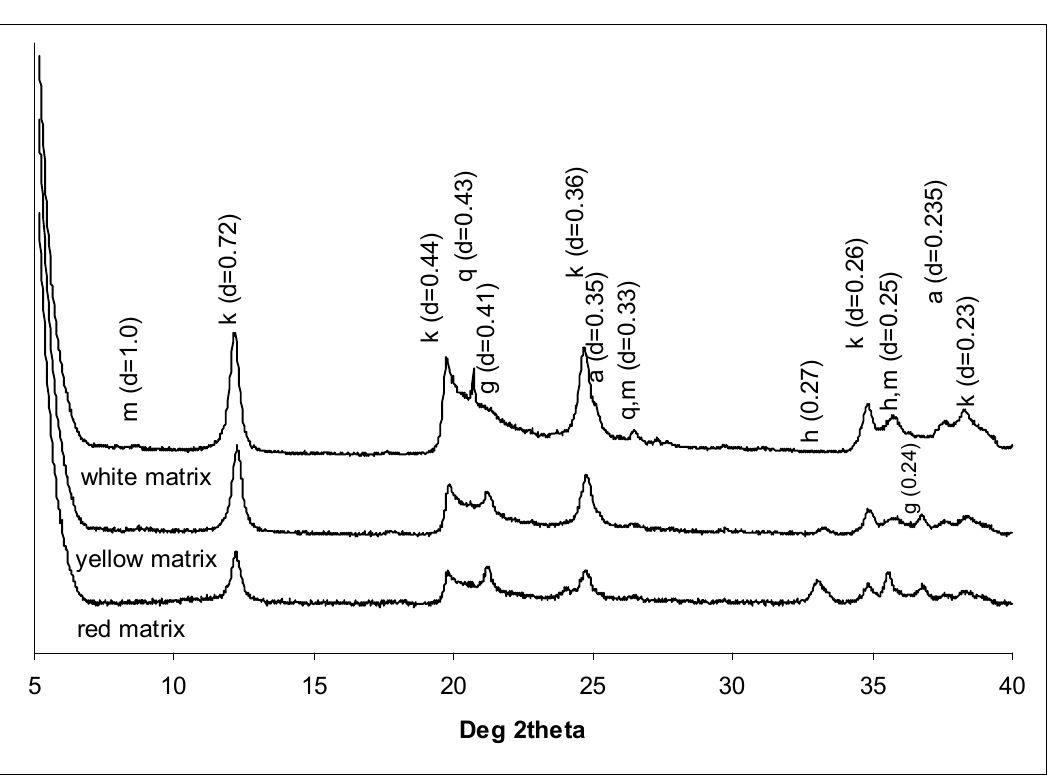
Figure 6. X-ray powder diffraction pattern of different soil matrixes with d -spacings (nm) and minerals: m—mica, k—kaolinite, g—goethite, h—hematite, a—anatase.